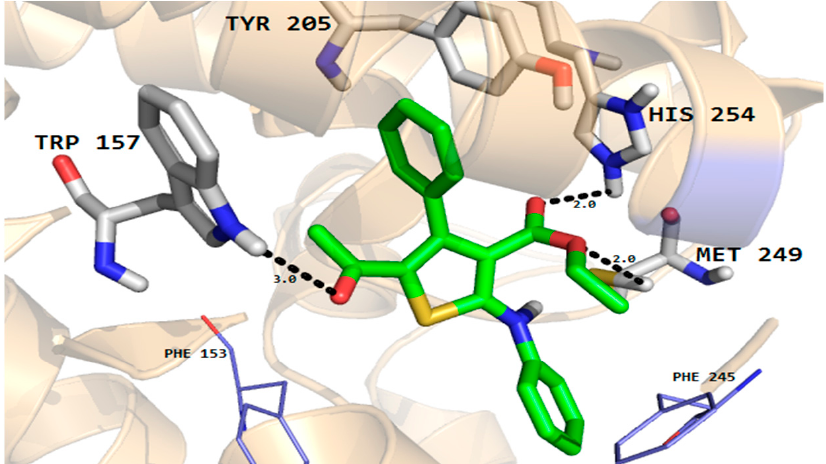
Molecules 2016 , 21 , 222